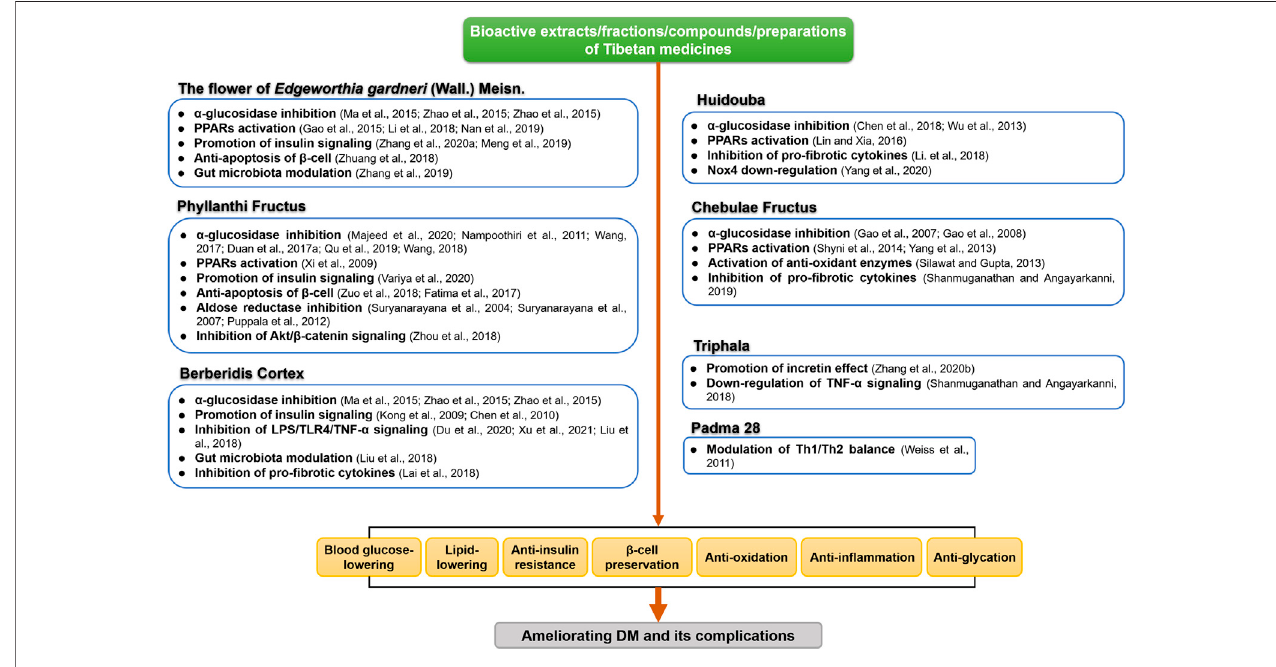
FIGURE 2 | Mechanisms of action of commonly studied anti-DM Tibetan